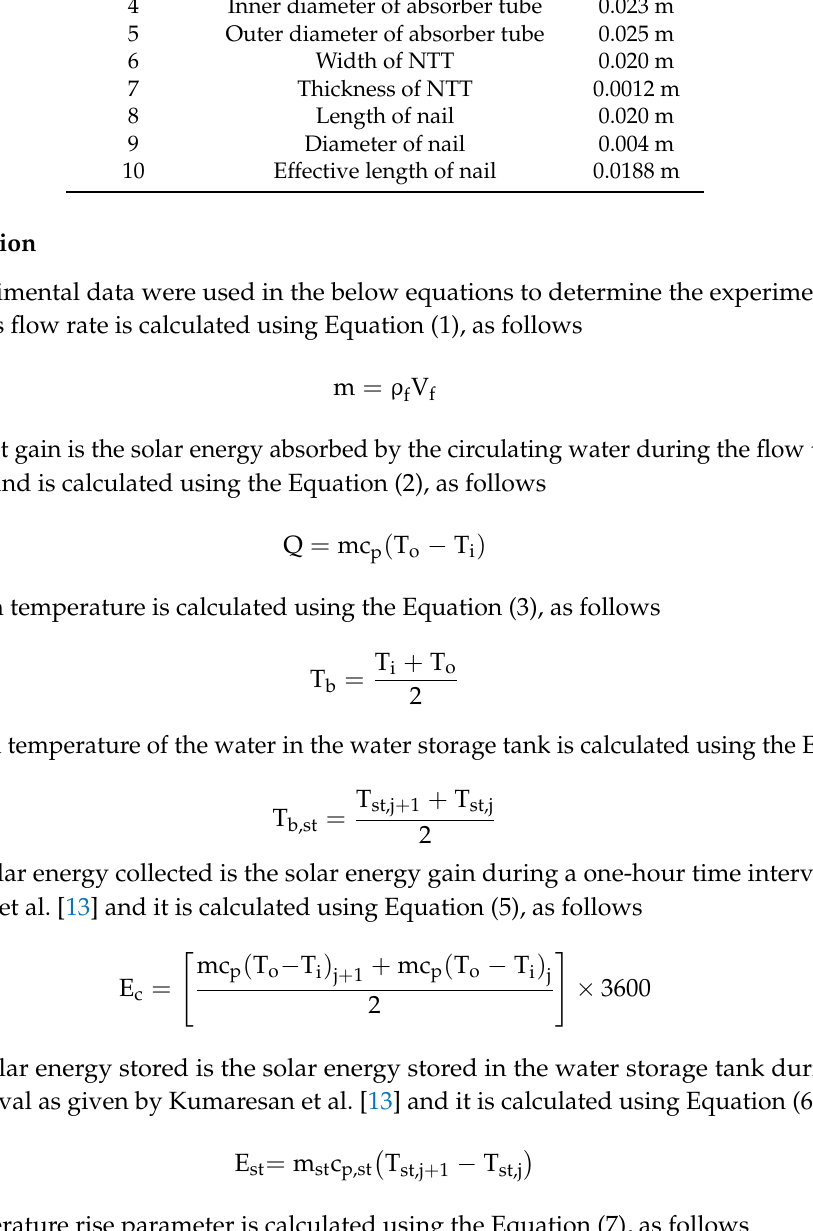
Table 1. Specifications of the CPCSWH experimental setup and NTT (nail type twisted tape). Sl. No. Parameter Value 1 Reflector aperture area 2.036 m 2 Length of absorber